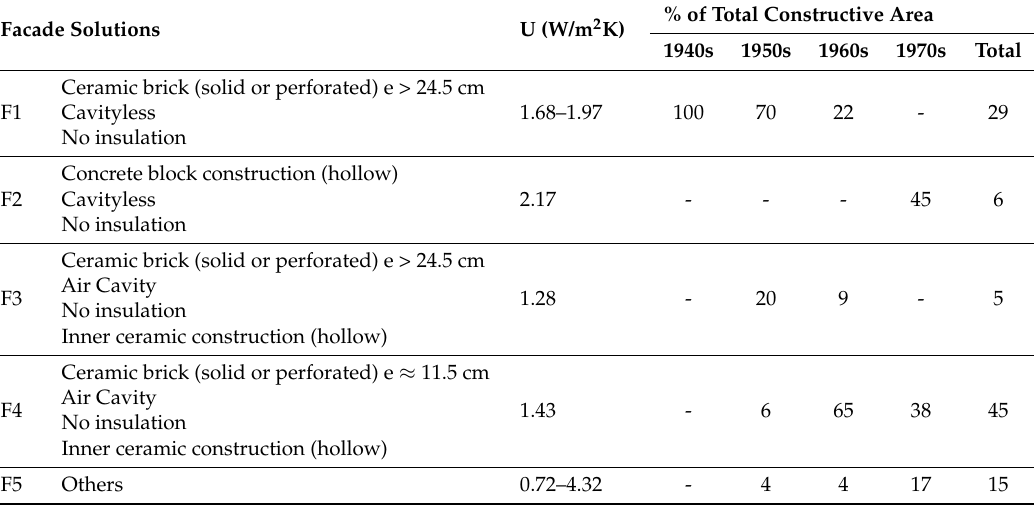
Table 1. Classification of the facade solutions of the housing stock by